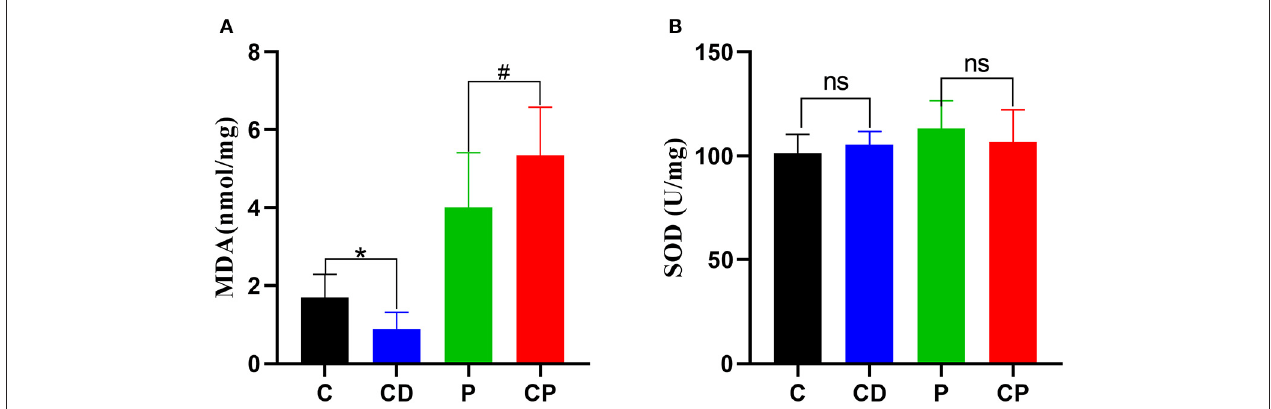
FIGURE 4 | The content of hepatic malonaldehyde (MDA) (A) and superoxide dismutase (SOD) (B) in liver ( n = 8–10). * P < 0.05; # P < 0.05; and ns P > 0.05.